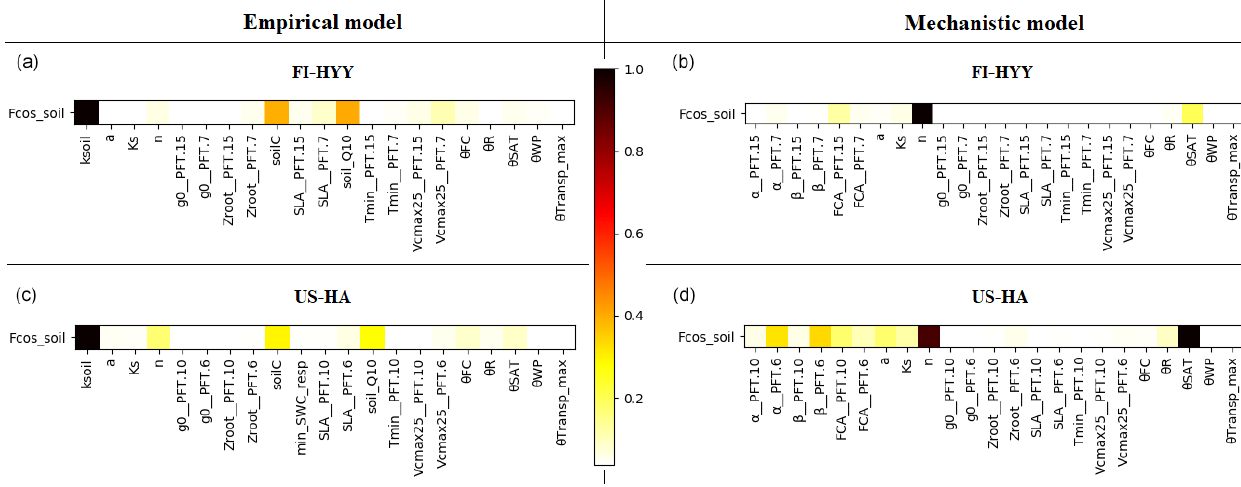
Figure 5. Morris sensitivity scores of the key parameters to which soil COS fluxes are sensitive, for the empirical (a, c) and the mechanis- tic (b, d) models. The two studied sites are FI-HYY (a, b) and US-HA (c, d) . Full descriptions of each tested parameter can be found in Tables S3 and S4 in the Supplement. The PFT is indicated at the end of the parameter names for the PFT-dependent parameters (at FI-HYY, PFT 7 is boreal needleleaf evergreen, and PFT 15 is boreal natural C 3 grassland; at US-HA, PFT 6 is temperate broadleaf summergreen, and PFT 10 is temperate natural C 3 grassland).